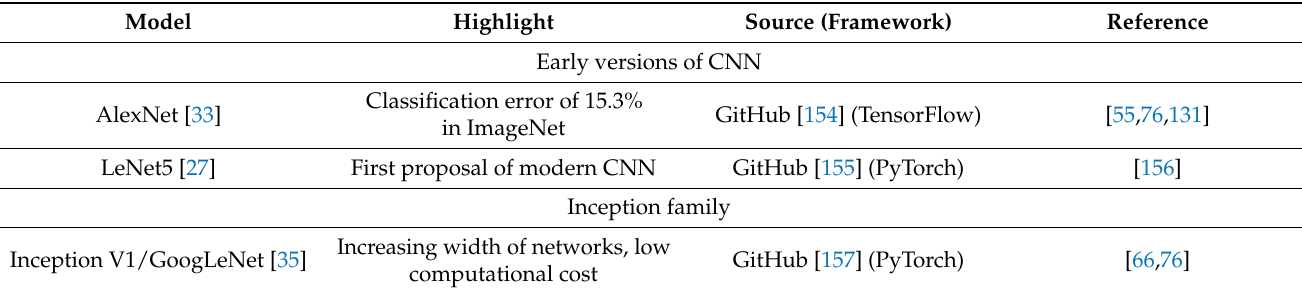
Table 3. Convolutional neural network architectures for image classification.